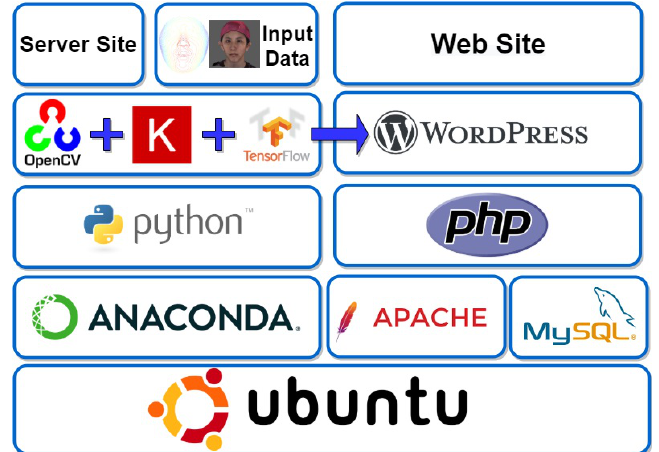
Figure 3. System architecture diagram.